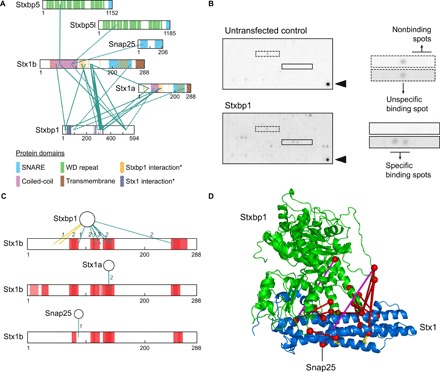
Peptide array analysis of selected cross-linked proteins.(A) Cross-link maps of selected SNARE proteins (dataset 1). Protein domains are depicted based on UniProt database and previous publications [*, from (31)]. Identified cross-links located in unique and shared peptides of Stx1a and Stx1b are represented as solid and dotted lines, respectively. (B) Results of Stxbp1 and control peptide array experiments. Examples of specific, nonspecific, and no binding signals are depicted. Arrowheads indicate antibody positive controls. Quantification and peptide sequences (two independent and two technical replicates) are described in fig. S9B and table S4. (C) Comparison of binding regions determined by peptide array (boxes colored in red) and XL-MS (edges). The number of samples in which the cross-links were identified is indicated on the edges (dataset 1). For peptide array assays, full-length proteins are shown as circles, and the protein used to generate peptide sequences in the arrays (Stx1b) is represented as sequence bars. Yellow edges match arrows with the same color in (D). (D) Cross-link mapping of Stxbp1 interactions. Stxbp1 (green) and Stx1 (blue) cross-linked sites were mapped onto the Stxbp1-Stx1 complex structure (PDB 3C98; Stx1 in closed conformation). Cross-links are indicated in red (if below DSSO maximal distance restraint) or in magenta (if exceeding DSSO maximal distance restraint). Yellow sticks show the two lysine residues of Stx1 (Lys45 and Lys55) found outside of the binding region with Stxbp1 as defined by the peptide array. Black edge indicates cross-linked site of Snap25.